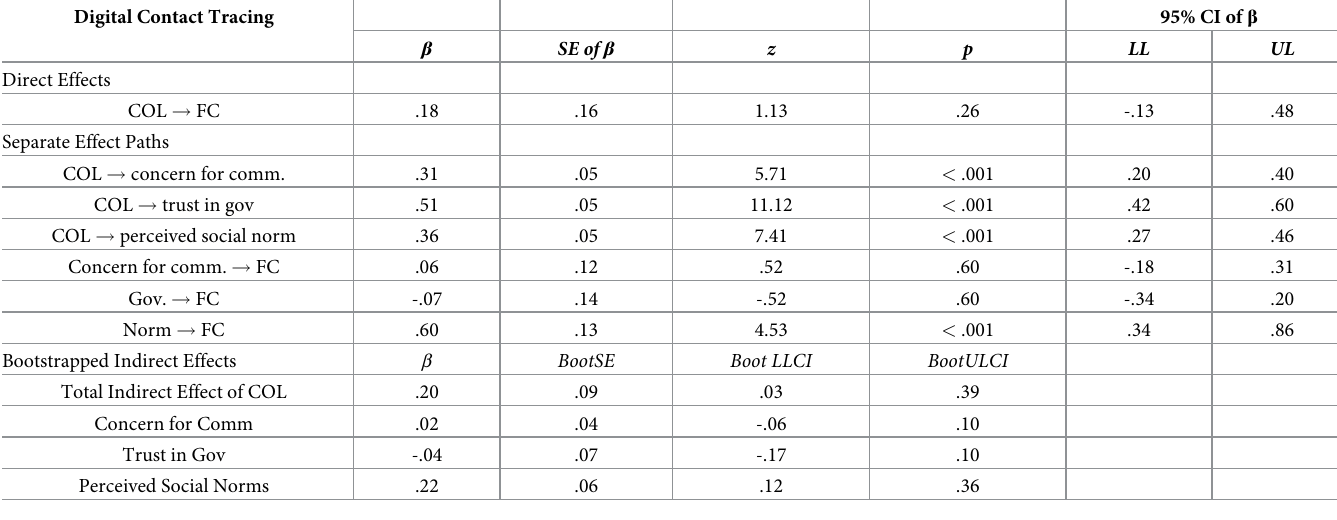
Table 7. Regression coefficients for mediation models